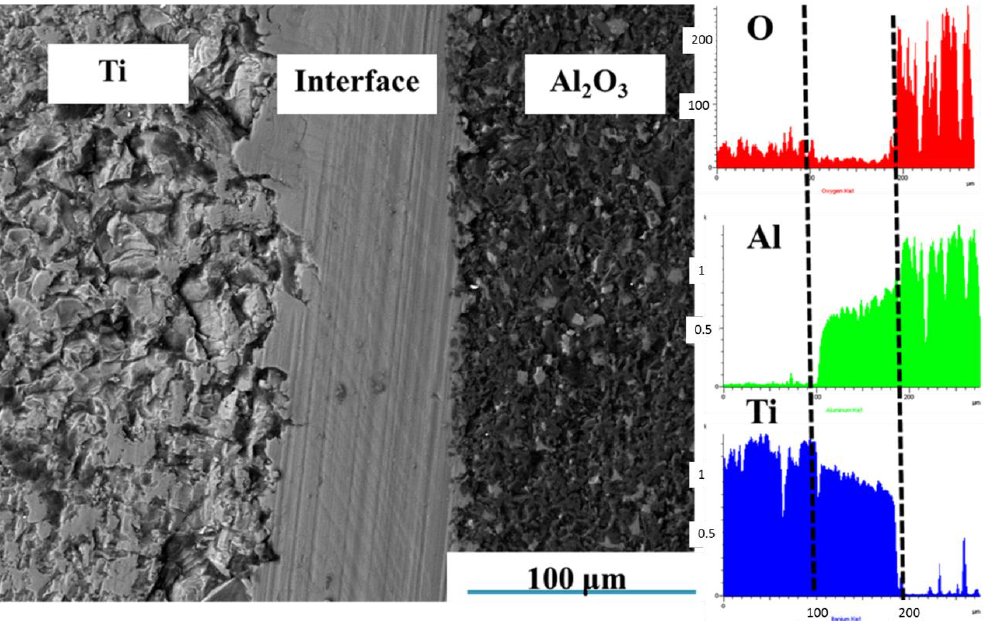
Figure 7. SEM images and line scanning analysis of the interface at 1450 °C with a holding time of 2 h.